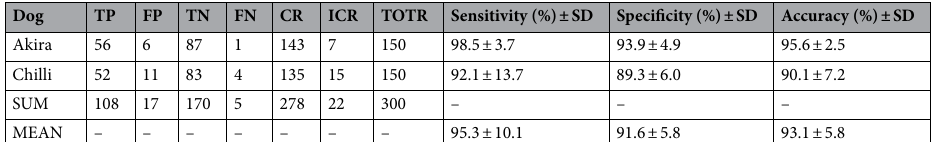
The two dogs detected ALB and CLB when searching on trees and untreated wooden pallets in the field with a mean accuracy of 93.1% (± 5.8 SD) (Fig. 1 and Table 3). Of the 300 scent samples searched, the dogs falsely detected ALB and CLB 17 times with a mean specificity of 91.6% (± 5.8 SD) and falsely rejected ALB and CLB five with a mean sensitivity of 95.3% (± 10.1 SD) (Fig. 1 and